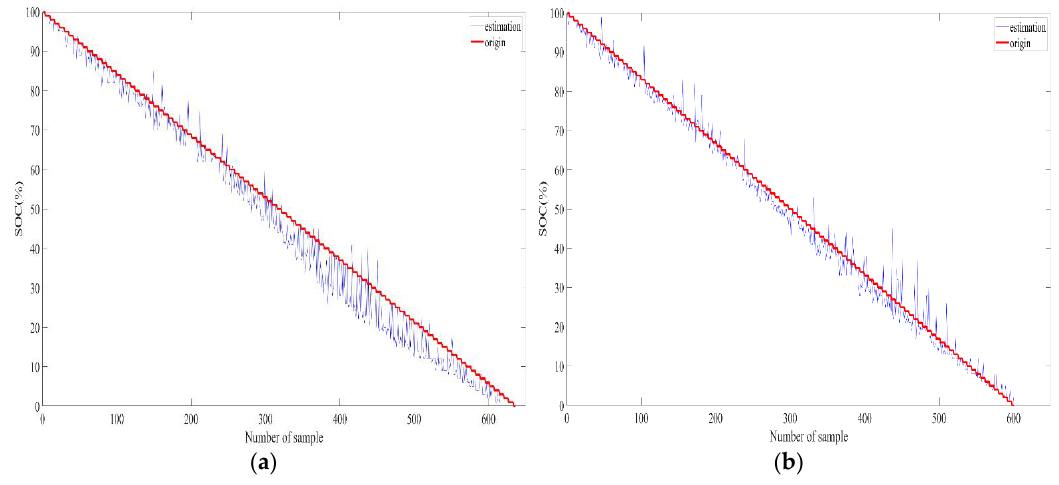
Figure 9. SOC estimation results ( a ) Using the LSTM utilizing only 6 voltage as the input value at room temperature ( b ) Using the LSTM utilizing only 6 voltage as the input value at high temperature.